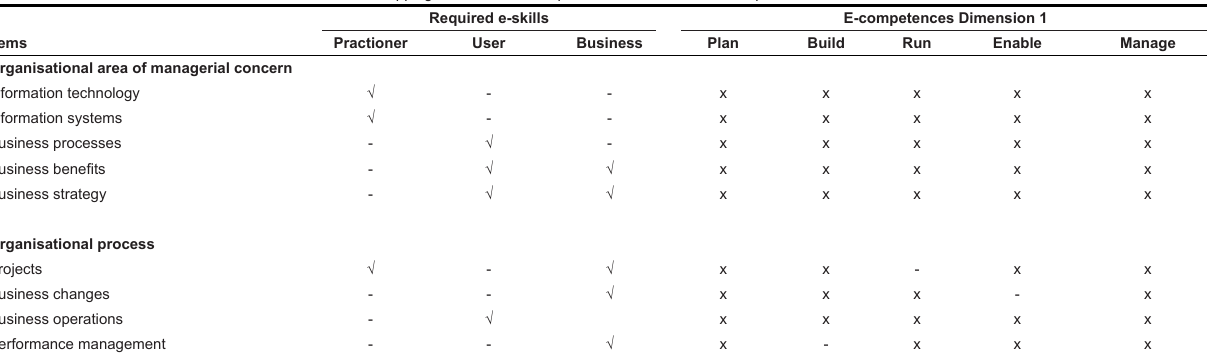
TABLE 2 Mapping e-skills and e-competence to IMBOK areas and processes